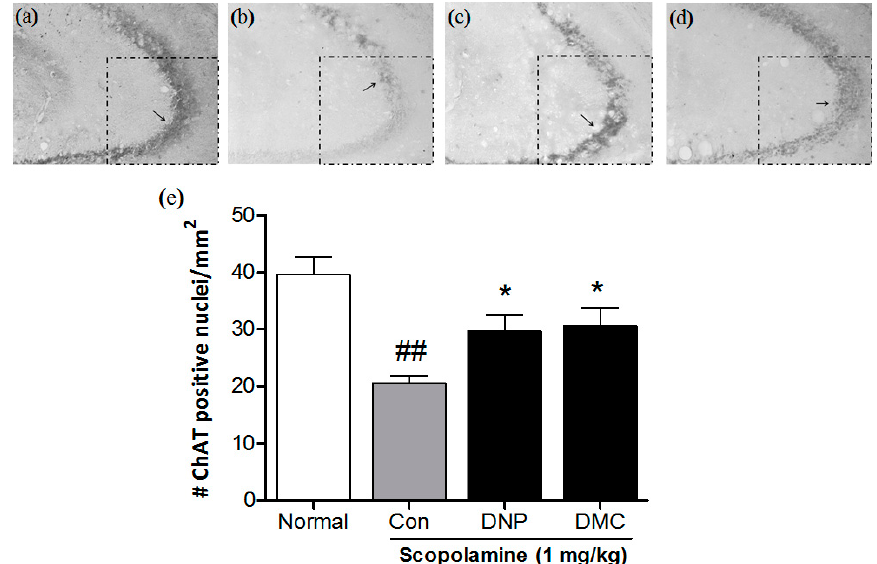
Figure 3. Effects of DMC on the choline acetyltransferase (ChAT) expression in the CA3 region of the hippocampus. Representative photomicrographs show ChAT-positive nuclei in the CA3 of ( a ) Normal (distilled water); ( b ) scopolamine (1 mg/kg); ( c ) DNP (2 mg/kg); and ( d ) DMC (10 mg/kg). Arrows indicate examples of ChAT-positive neurons; ( e ) Columns show the means ± SEMs ( n = 8) values of ChAT expression in the CA3 region of the hippocampus. ## p < 0.01 as compared to the vehicle-treated normal group; * p < 0.05 as compared to the scopolamine-treated control group.